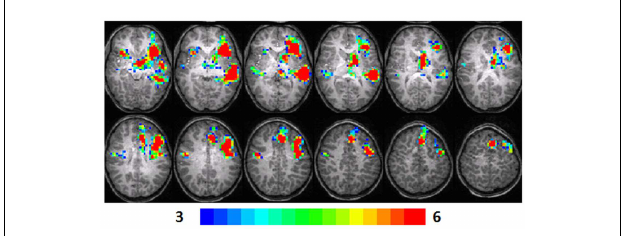
FIGURE 1 | Composite fMRI activation maps for the verb generation (verb generation > finger tapping) inT1 children ( N = 16). The contrast is significant at p < 0.001 (corrected), slice thickness is 5mm for these contiguous slices. Slices range from z = 13 to 24 in theTalairach frame. Cluster size is 30 voxels. Higher significance is indicated in hotter color ( t threshold ranged from 3 to 6, see scale in the bottom of the figure). Figure is presented in a radiological orientation (L = R, R = L).